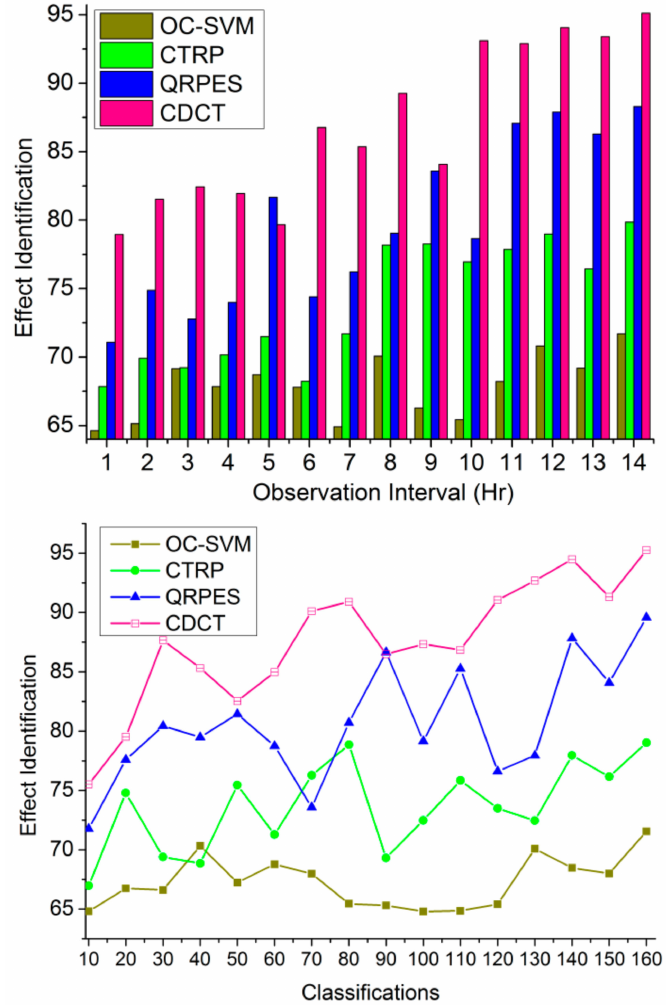
Figure 12. Effect Identification for Individual